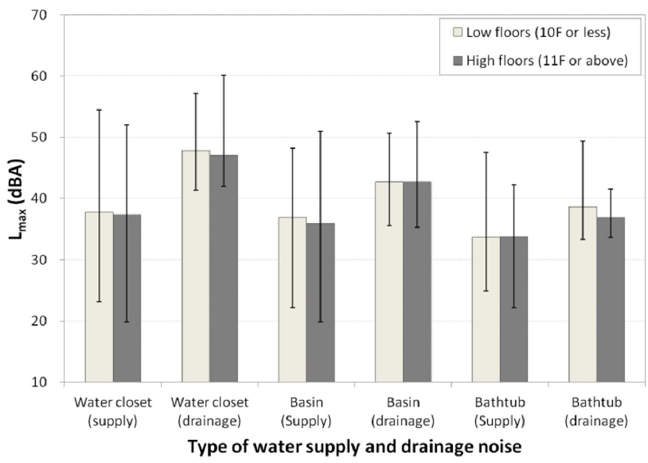
Figure 11. Water supply and drainage noises (L AFmax ) according to the groups of low ( N = 60) and high ( N = 53) floors.